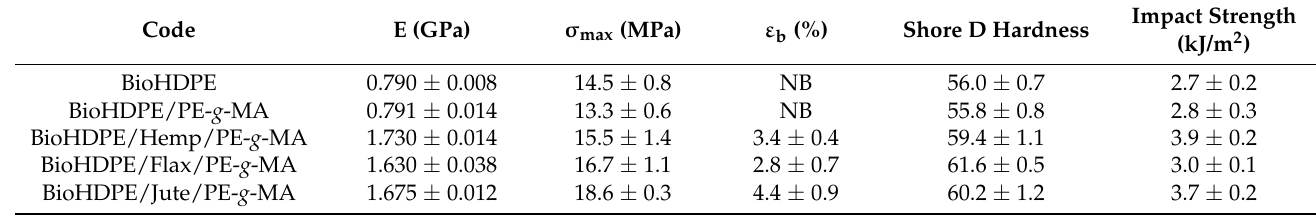
Table 2. Summary of mechanical properties of the injection-molded parts of BioHDPE-natural fiber composites in terms of: